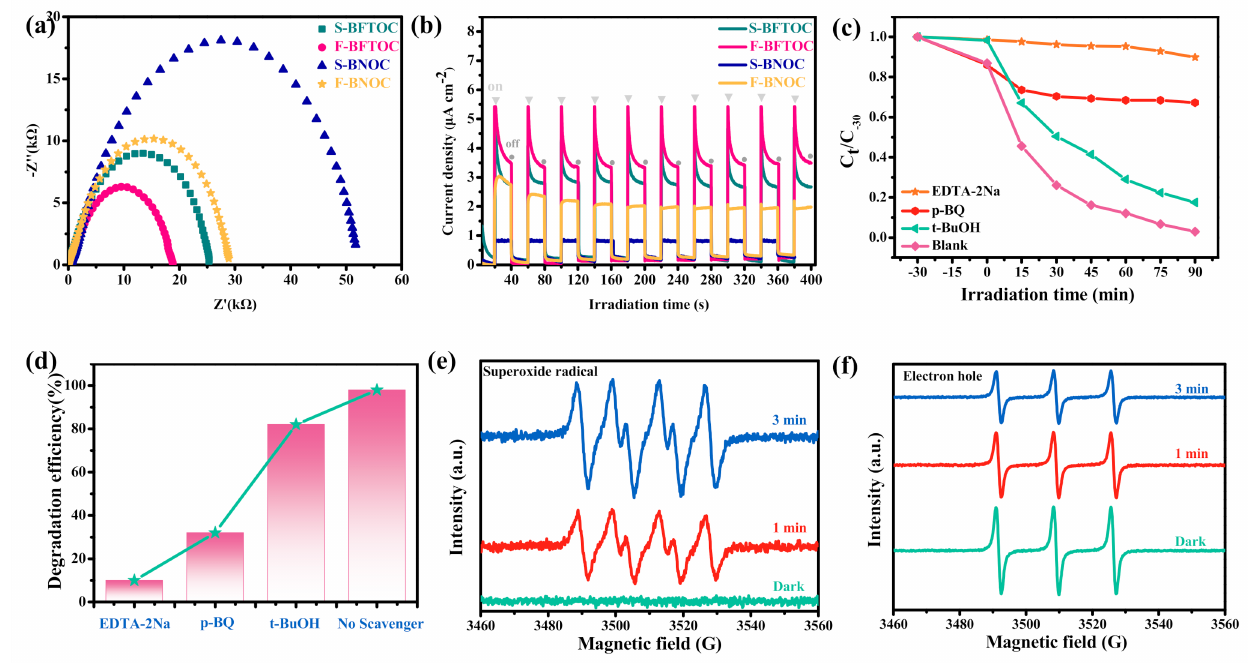
Figure 7. ( a ) EIS Nynquist plots of F-BFTOC, S-BFTOC, F-BNOC and S-BNOC, respectively; ( b ) Transient photocurrent densities of F-BFTOC, S-BFTOC, F-BNOC and S-BNOC, respectively; ( c , d ) The photocatalytic performance of F-BFTOC with different scavenges under visible light irra- diation; ( e ) DMPO-O 2 − spin-trapping ESR spectra of F-BFTOC; ( f ) TEMPO-h + spin-trapping ESR spectra of